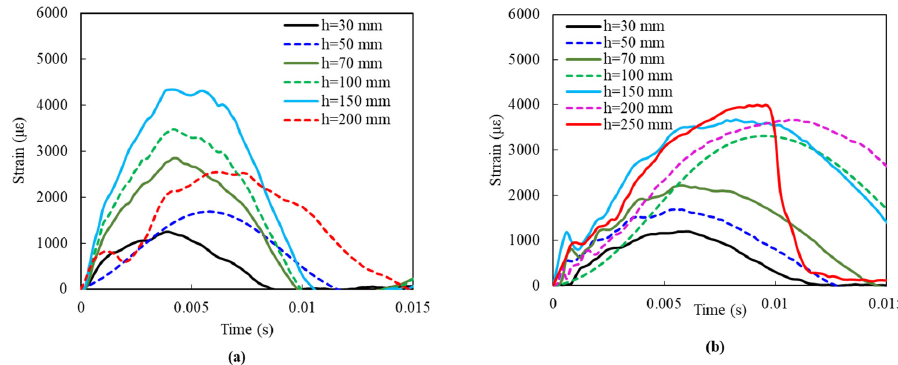
Figure 11. FFRP strain of ( a ) G1 and ( b ) G2 slabs.